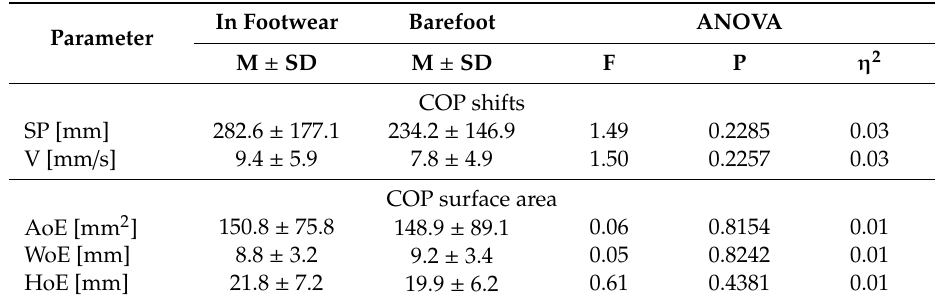
Table 4. Means and standard deviations for posturographic measures recorded among pentathletes during aiming-in-shooting position, with and without footwear; along with the results of one-way ANOVA with footwear